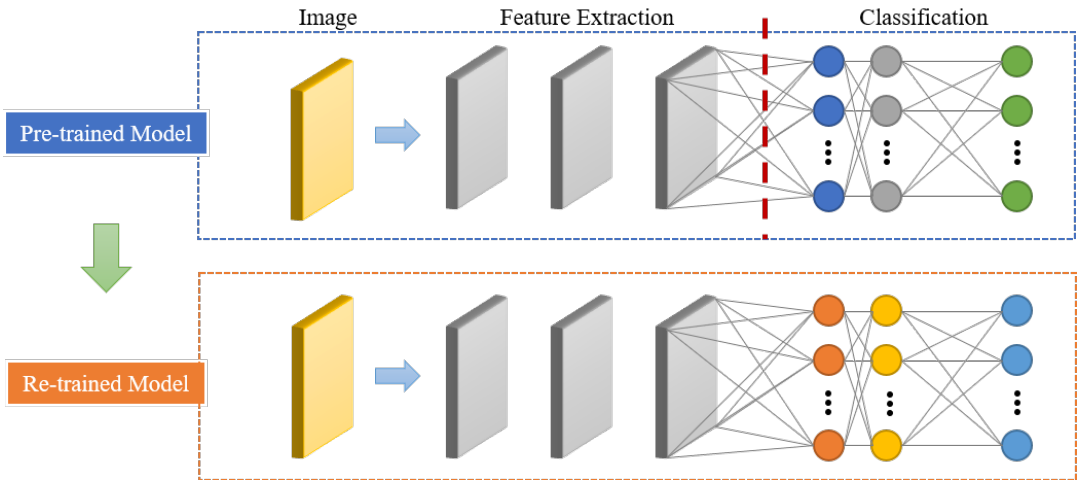
Figure 1. Concept of transfer